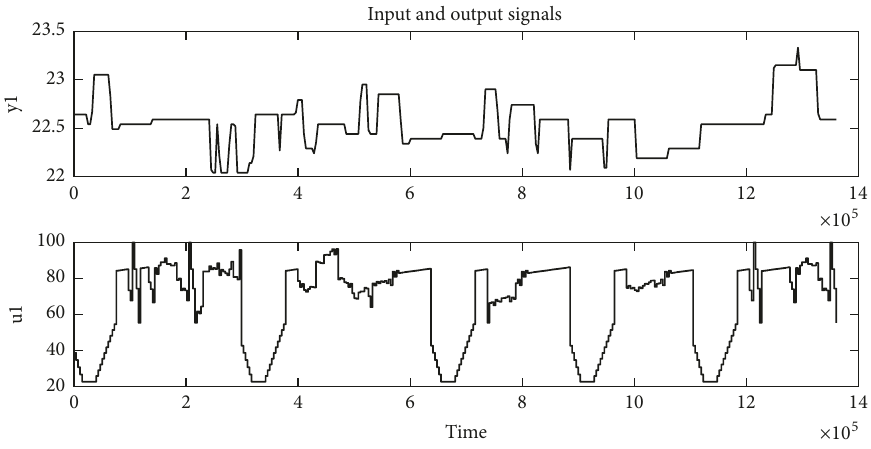
Figure 23: Input and output signals of zone temperature of AHU1.